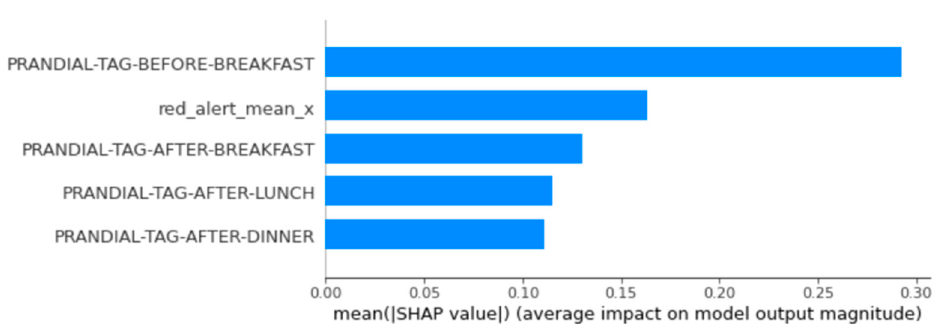
Figure A3. SHAP feature importance ranking for model trained on Tags and High-Readings.